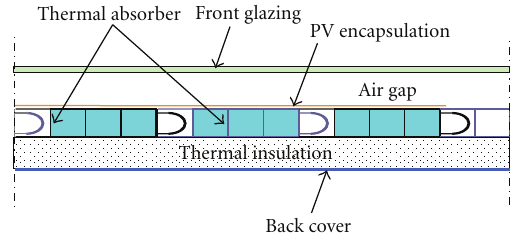
Figure 1: Cross-sectional view of the PV/T collector showing several absorber modules in integration (N.T.S).